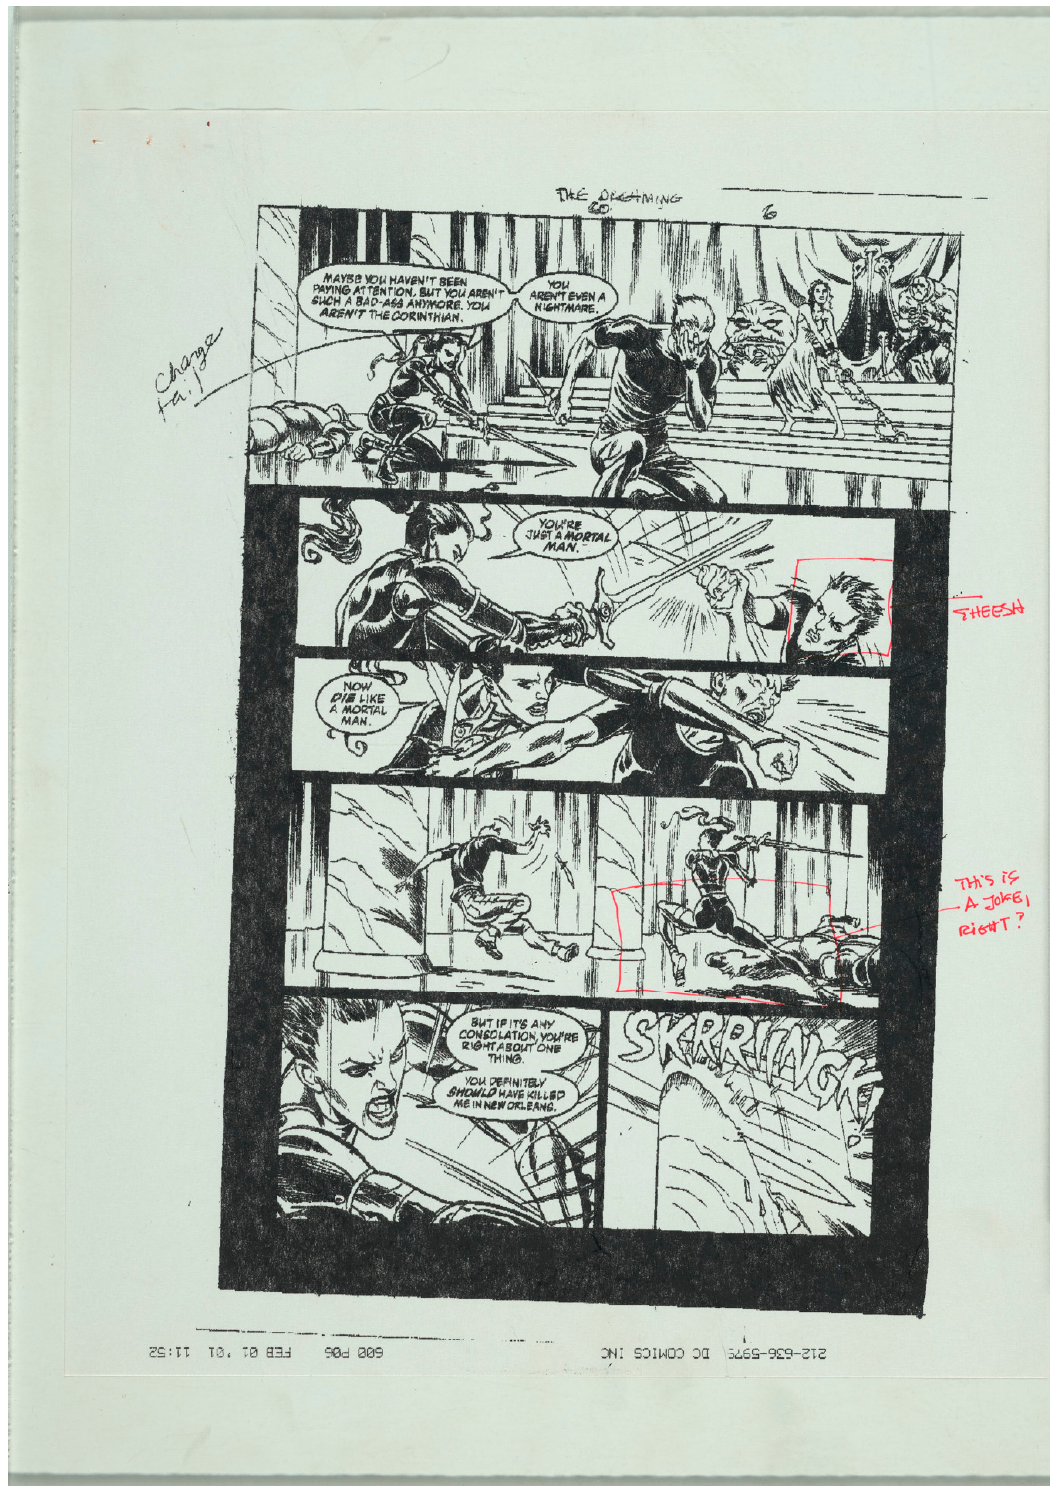
Figure 2. Draft of The Dreaming #60 page 6 with Kiernan’s handwritten remarks.